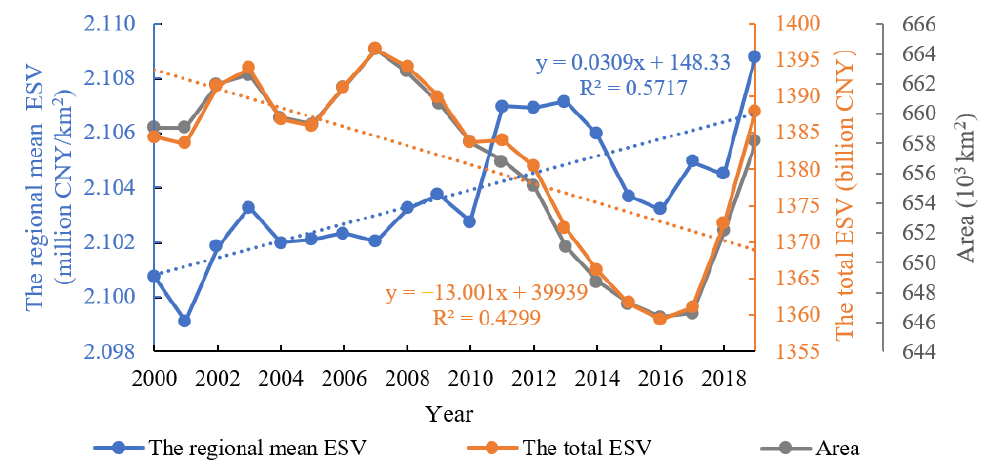
Figure 5. Trends of the average grassland ESV in Inner Mongolia from 2000 to